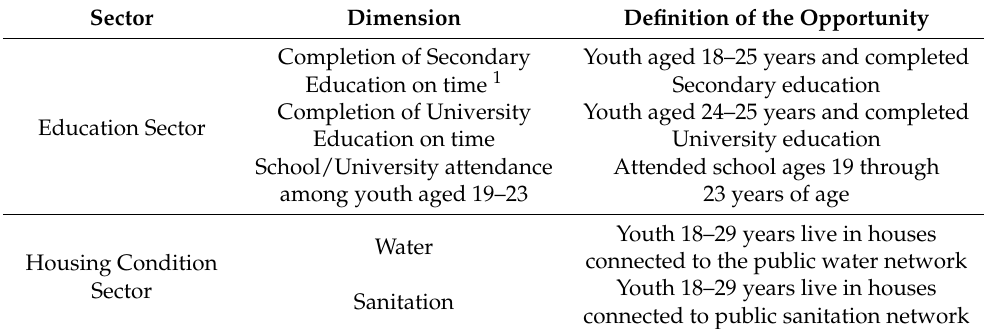
Table 2. Definitions of dimensions of opportunities among Moroccan youth aged 18–29